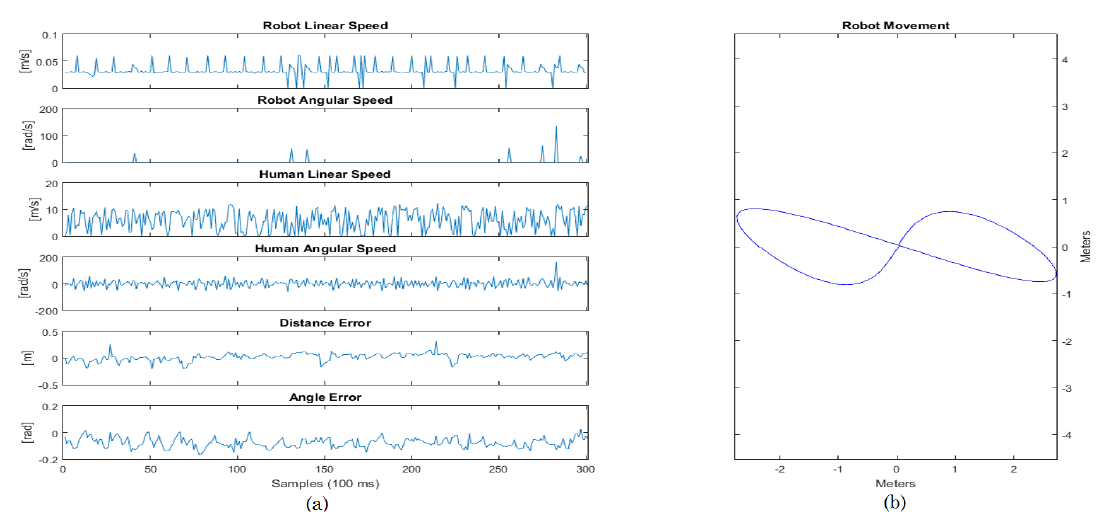
Figure 23. Results for the Lemniscate curve. ( a ) Graphical data about the experiment; ( b ) Graphical path of the